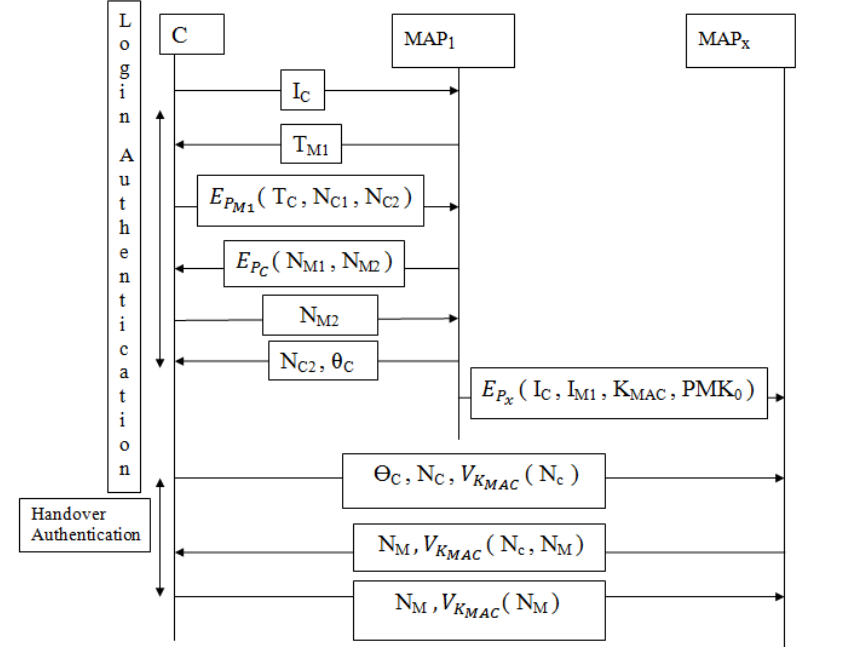
Figure 2. Li et al. [12] protocol during LAP and